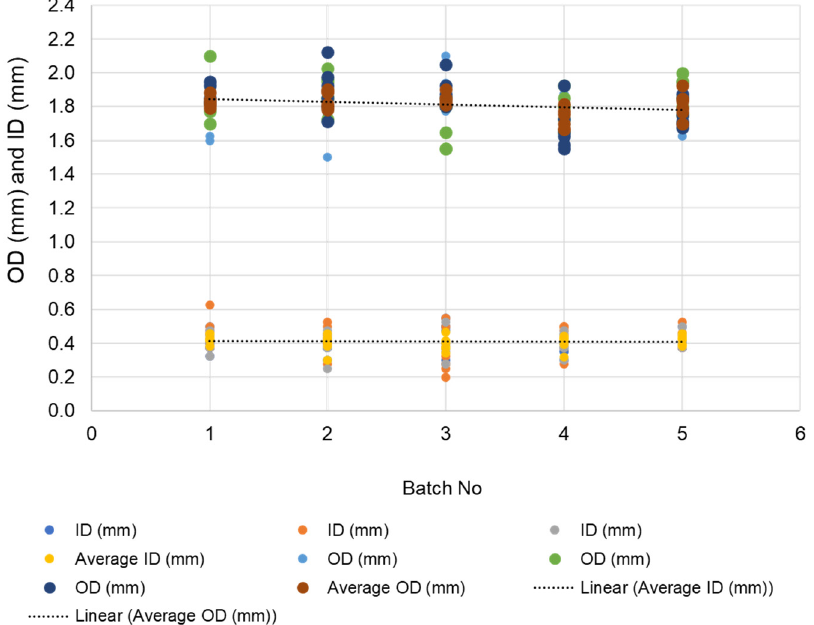
Figure 3. Outer diameter (OD) and inner diameter (ID) of the three bores, along with the average of OD and ID of the tri-bore hollow fiber membranes.